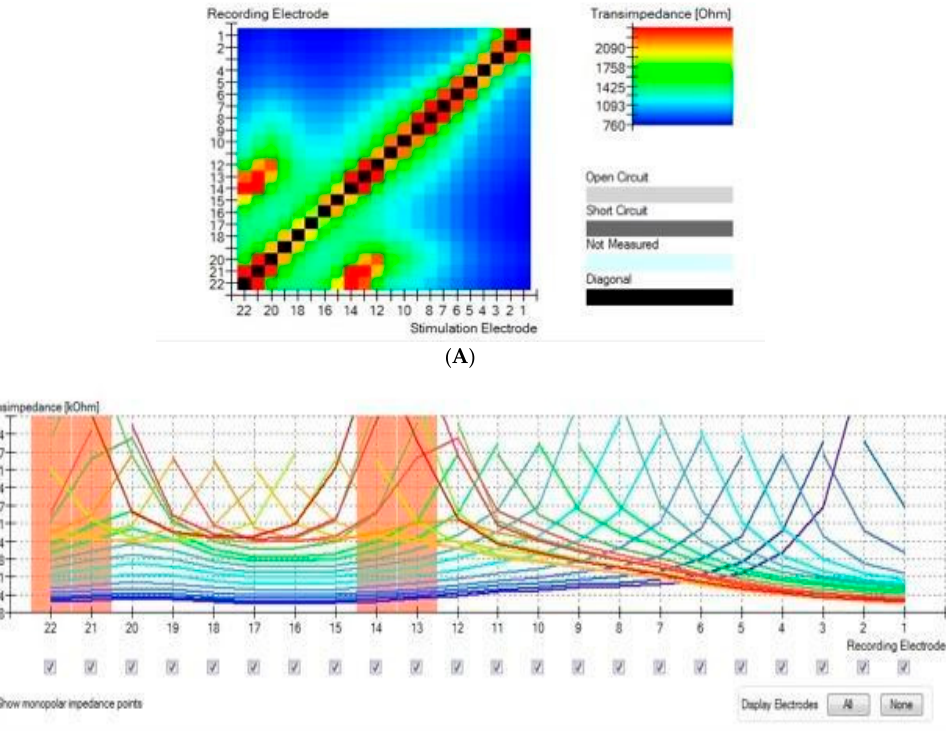
Figure 2. TransImpedance Matrix (TIM) presented in a line graph.